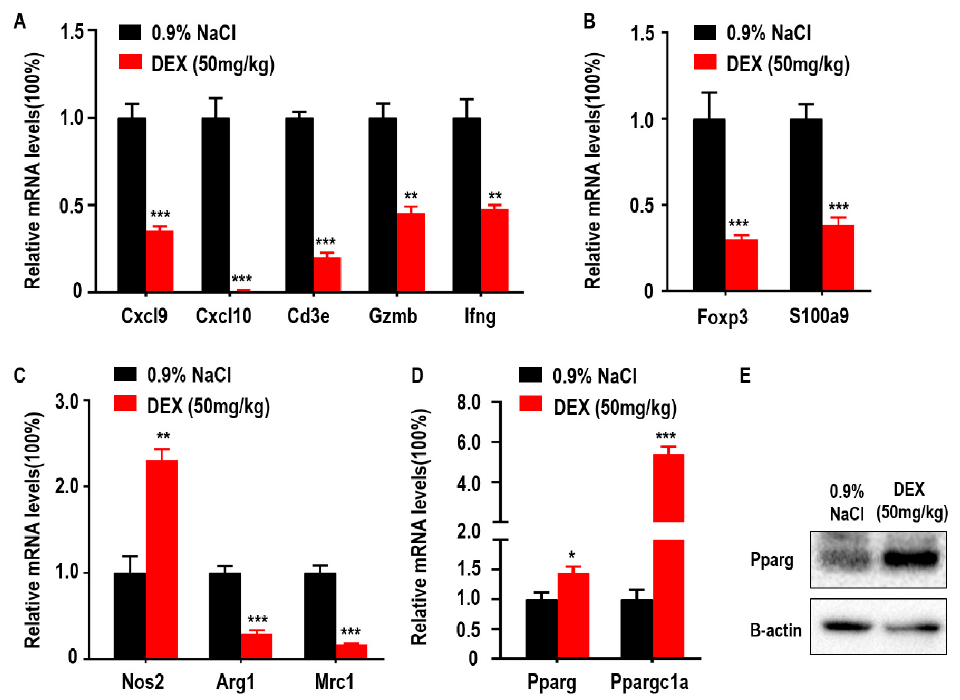
Figure 2. High-dose DEX inhibited anti- or pro-tumor immune response in most cells, but promoted M1-like tumor-associated macrophages (TAMs) polarization and peroxisome proliferator-activated receptor γ (Pparg) expression in the tumor microenvironment (TME). ( A ) Intratumoral genes relevant to the anti-tumor T cell-mediated antitumor immune response. ( B ) Protumor immune cell regulatory T cells (Tregs) and myeloid-derived suppressor cells (MDSCs) markers. ( C ) Antitumor M1-like TAMs or protumor M2-like TAMs markers. ( D , E ) The expressions of Pparg and Ppargc1a were determined via qPCR or Western blotting of tumors taken from C57BL/6 mice treated with 0.9% NaCl or 50 mg/kg DEX. All data are presented as mean ± SEM and p < 0.05 is considered significant (* p < 0.05, ** p < 0.01, *** p < 0.001; n = 3 mice per group). Results representative of three independent experiments. 2.3. High-Dose DEX Inhibited Tumor Progression Accompanied with Glucose and Lipid Metabolism Suppression in the